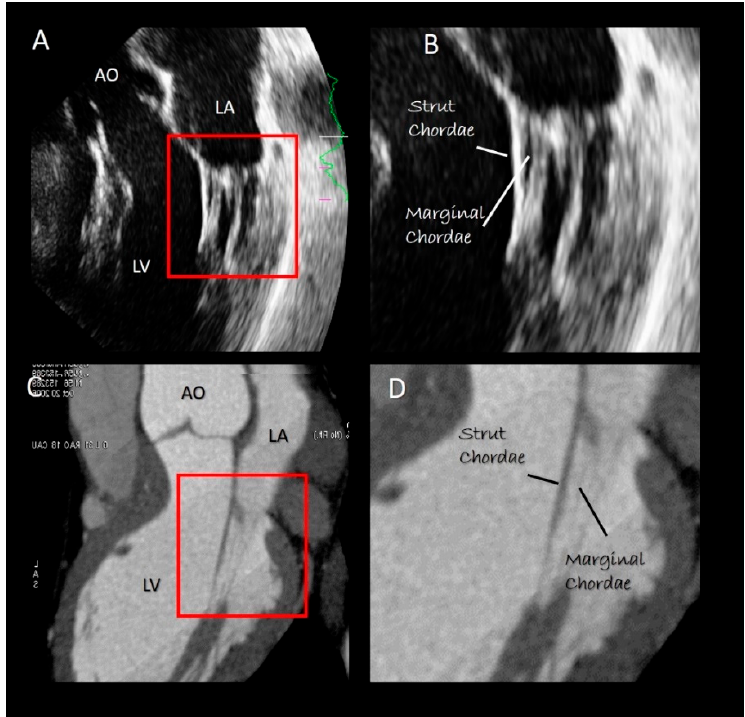
Figure 7. ( A ) 2D TTE and ( C ) CT cross section in long-axis view. ( B , D ) Magnified images of the structures inside the red rectangle of panel A and C, respectively, showing the strut and marginal chordae (see text).